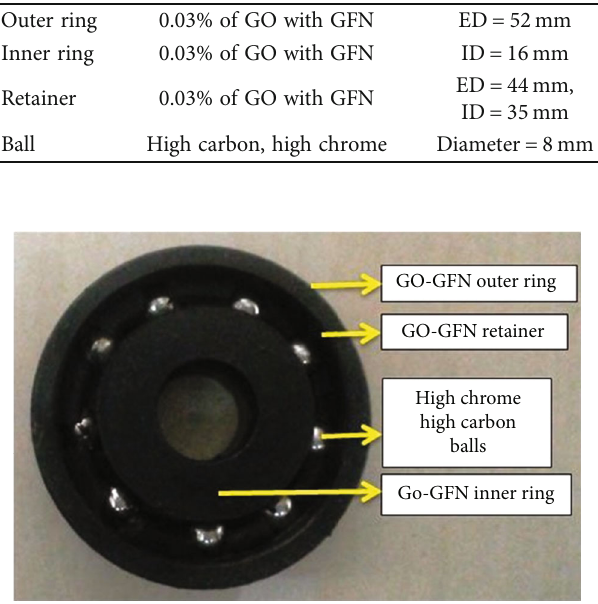
Figure 4: Fabricated hybrid GO-GFN nanopolymer bearing.